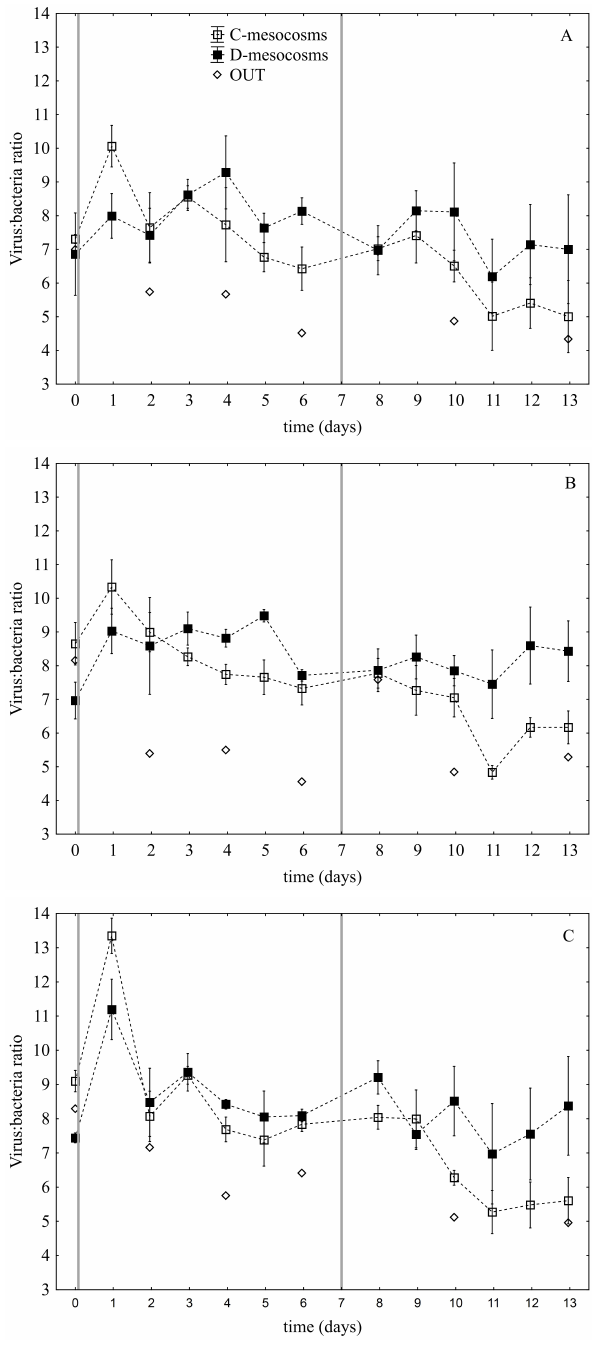
Figure 7. Ratios virus and bacterial abundance (mean ± standard deviation of three replicate mesocosms) in D- and C-mesocosms and OUT samples at surface (a) , 5 (b) and 10 (c) m depth during the DUNE-R experiment. Grey vertical bars represent the dust seed- ings.